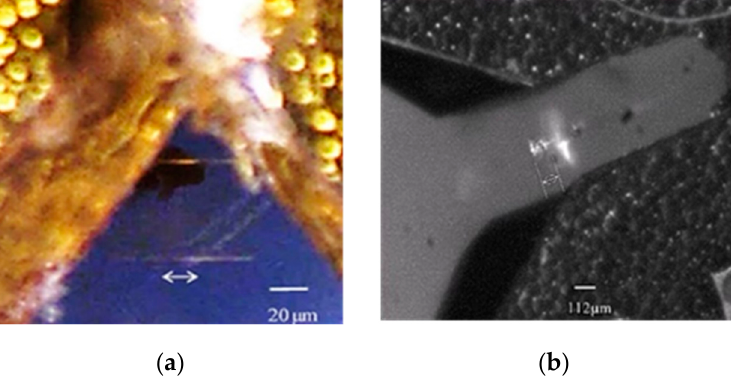
Figure 24. Pictures show superimposition of waveguide’s peak displacement in ( a ) horizontal and ( b ) vertical direction. Both displacements are operated at 1 Hz ± 150 V AC and 100 V DC. Black spot on proof mass in left image is the silicon residue.